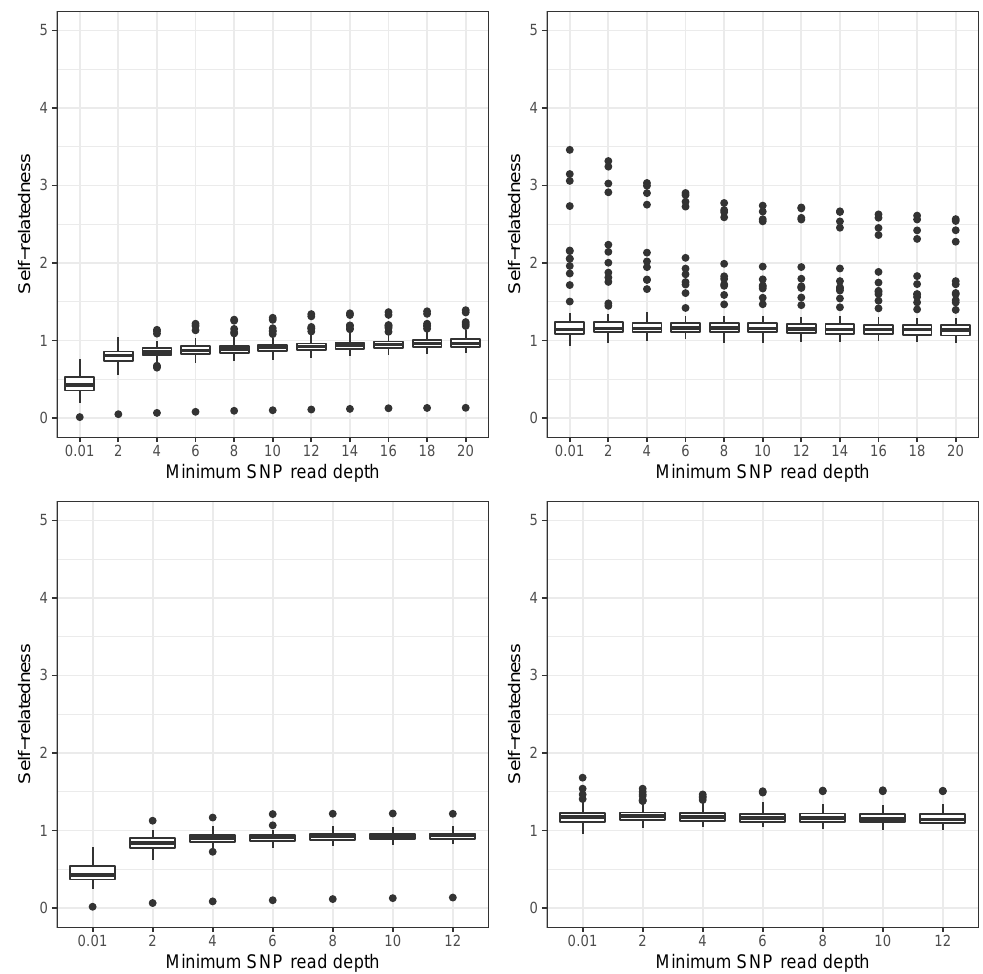
Figure 6. Self-relatedness distribution. Distribution of estimated self-relatedness under different minimum SNP read depth thresholds in the whole population ( upper plots ) and only E.nitens population ( bottom plots ) using G1 [42] ( left plots ) and G5 [59] ( right plots ) relationship matrices.